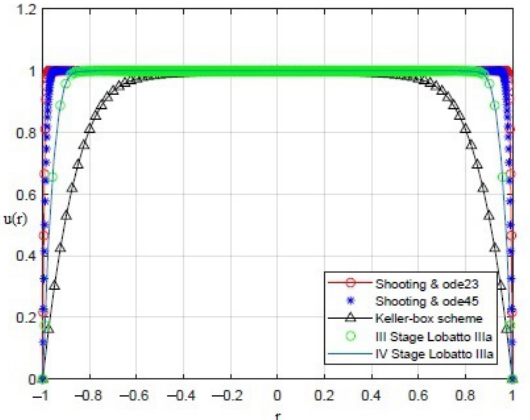
Figure 7. Recovering of u ( r ) for δ = 1.99 and θλ 2 as reported in Tables 1 and